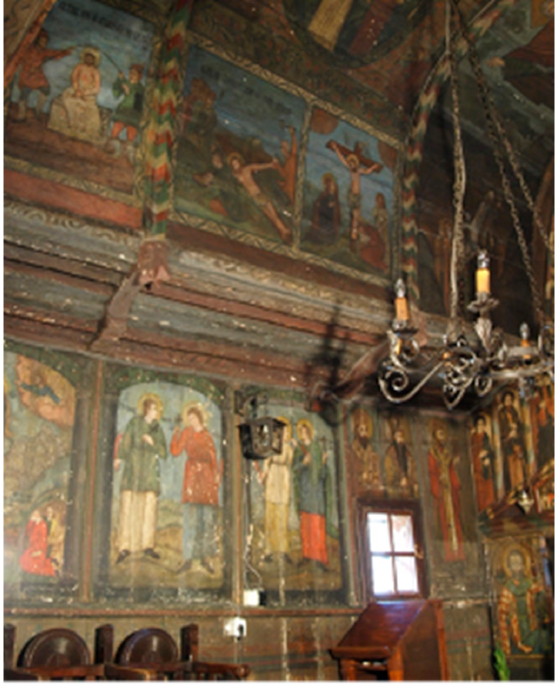
Figure 2. The interior of church nave – eastern part used for sampling .